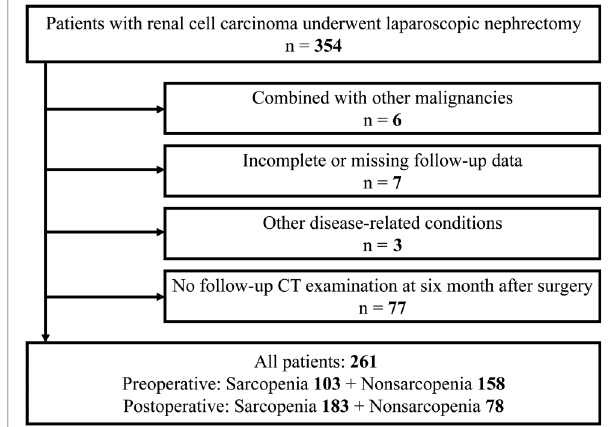
FIGURE 1 | Schematic fl ow diagram for our study